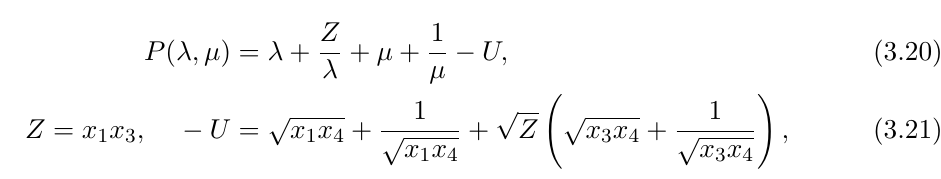
( P ) of the curve P ( e x +i θ , e y +i φ ) = 0 . Red lines are for θ = const , blue A over ( P ) . Boundaries γ i of C P A . The projections of A and B cycles are drawn A − − ( x, y ) for the same P −R